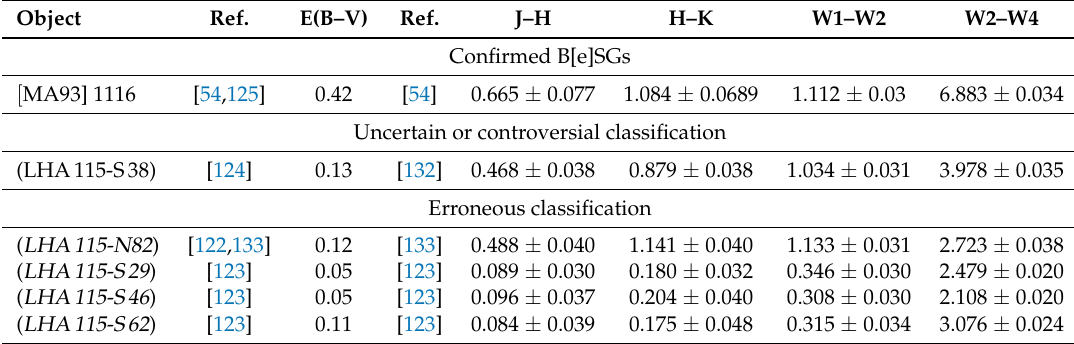
Table 5. Confirmed and candidate B[e]SGs in the SMC. Misclassified objects are listed in the bottom part of the